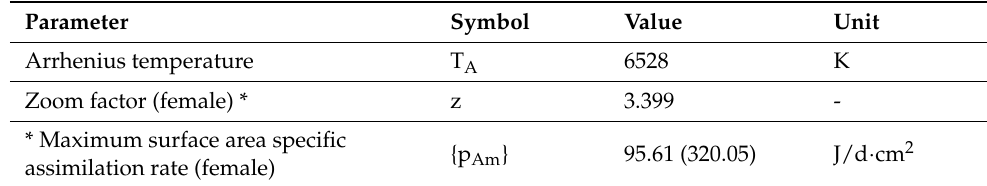
(cid:8) . (cid:9) = z [ . p M ] p L ref m , Am κ